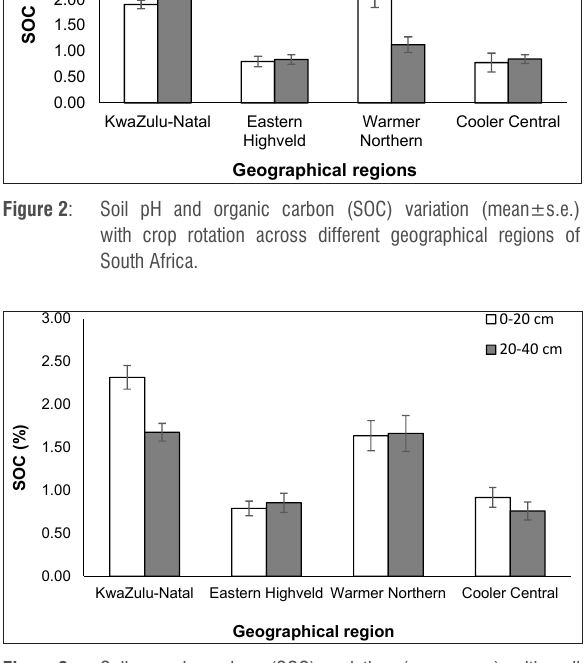
Figure 3 : Soil organic carbon (SOC) variation (mean±s.e.) with soil depth in different geographical regions of South Africa. Particle size distribution for wheat production soils in different geographical regions of South Africa Geographical region